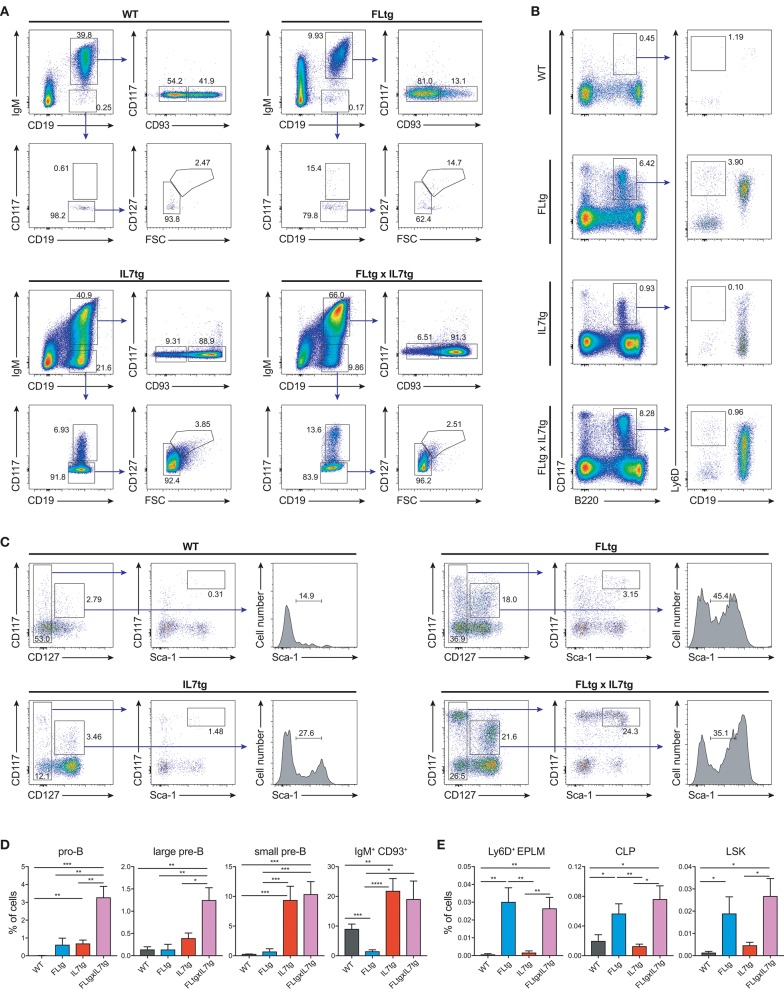
Hematopoietic progenitors in the blood of FLtgxIL7tg mice. (A) Representative FACS plots for the identification of B cell progenitor stages in the blood of WT (upper left), FLtg (upper right), IL7tg (lower left) and FLtgxIL7tg (lower right) mice. Gate numbers indicate frequencies of parent gate. (B) Representative FACS plots for the identification of Ly6D+ EPLM in the blood of WT (upper left), FLtg (upper right), IL7tg (lower left), and FLtgxIL7tg (lower right) mice. Gate numbers indicate frequencies of parent gate. In every panel the left plot (CD117 vs. B220) shows live, NK1.1−CD11c−SiglecH− cells. (C) Representative FACS plots for the identification of LSK and CLP in the blood of WT (upper left), FLtg (upper right), IL7tg (lower left), and FLtgxIL7tg (lower right) mice. Gate numbers indicate frequencies of parent gate. In every panel the left plot (CD117 vs. CD127) shows live, Lin− cells. (D) Percentages of pro-B (CD19+IgM−CD117+), large pre-B (CD19+IgM−CD117−CD127+FSClarge), small pre-B (CD19+IgM−CD117−CD127−FSCsmall) and immature B cell (CD19+IgM+CD93+) progenitors in the blood of WT (n = 9), FLtg (n = 11), IL7tg (n = 8), and FLtgxIL7tg (n = 11) mice. B cell progenitors were identified by FACS as shown in (A). (E) Percentages of Ly6D+ EPLM (CD11c−NK1.1−SiglecH−B220intCD117intLy6D+CD19−), CLP (Lin−CD117intSca1intCD127+) and LSK (Lin−CD117+Sca1+CD127−) progenitors in the blood of WT (n = 6), FLtg (n = 6), IL7tg (n = 7), and FLtgxIL7tg (n = 10) mice. The y-axis on all plots indicates % of live, nucleated blood cells. *p < 0.05, **p < 0.01, ***p < 0.001, and ****p < 0.0001. Error bars indicate standard deviation.